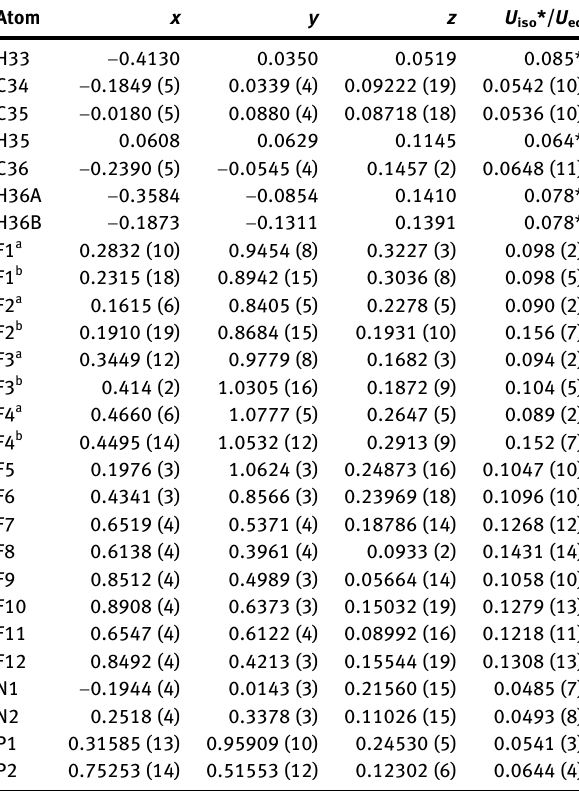
Table  : Fractional atomic coordinates and isotropic or equivalent isotropic displacement parameters (Å 